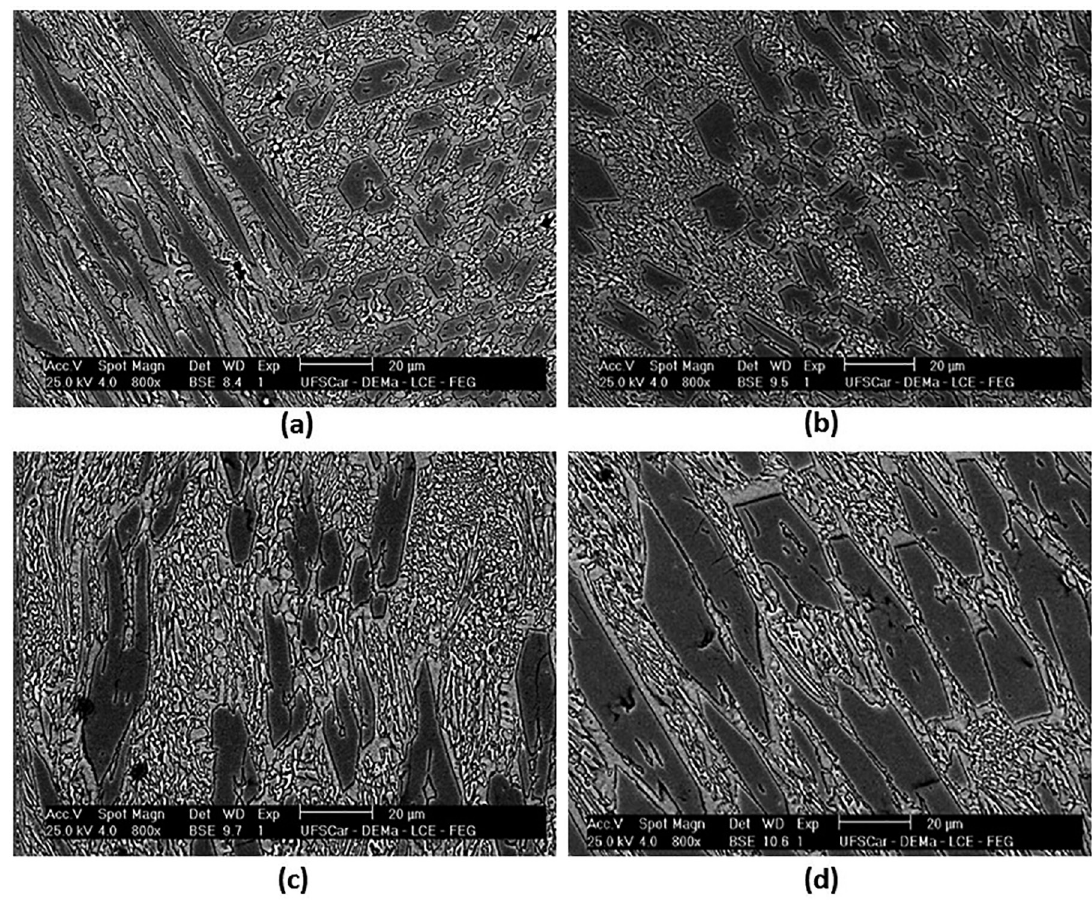
Figure 7: SEM of the Fe-Cr-C hardfacing for (a) pulling the torch, (b) pushing the torch, (c) one deposited layer and (d) two deposited layers.